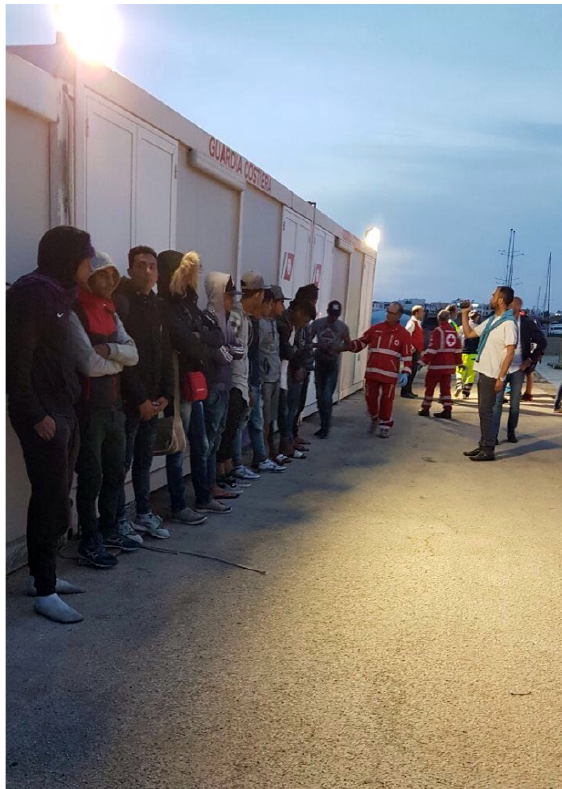
Figure 5. Lampedusa, May 2017. Used with permission from Red Cross